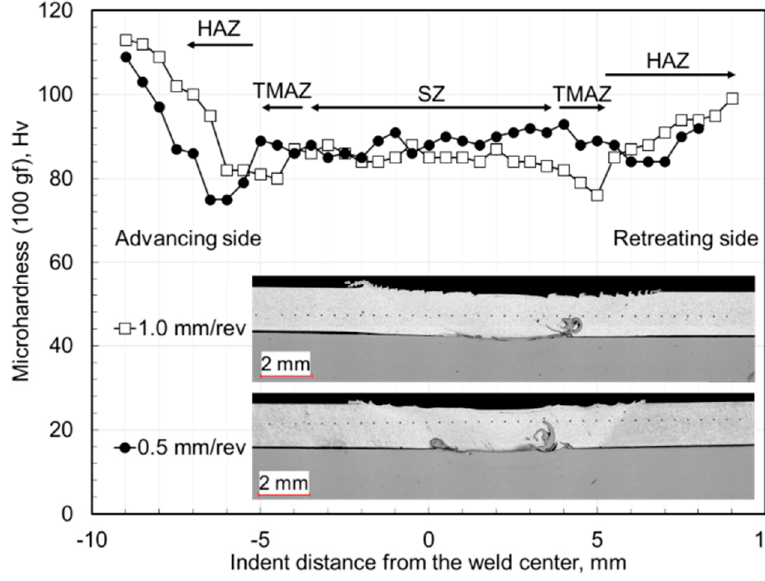
Figure 16. Microhardness profiles of the aluminum sections with different RPs.